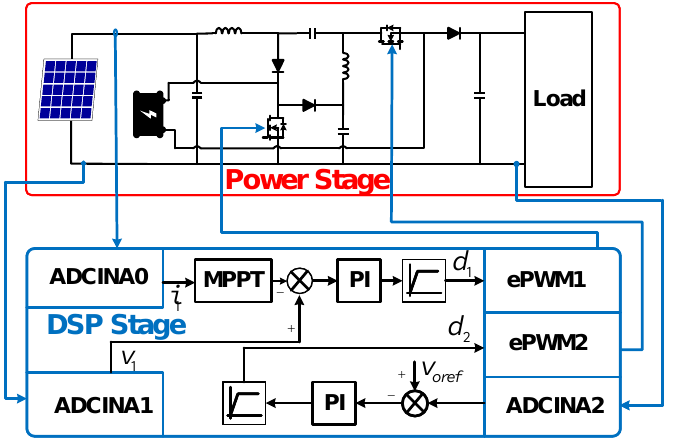
Figure 6. Control block diagram of the proposed